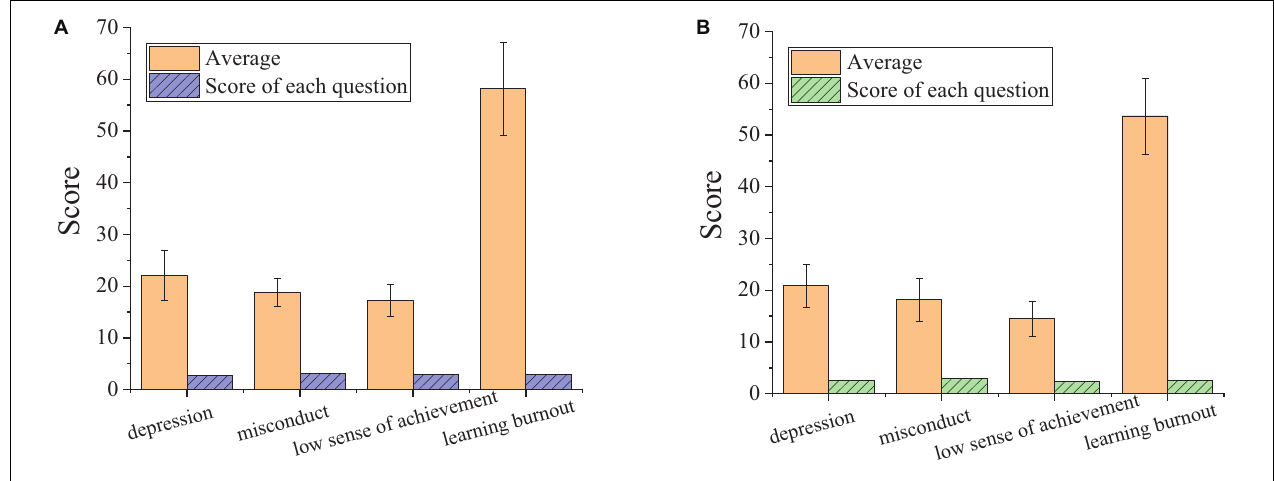
FIGURE 6 | Descriptive statistics for learning burnout of Chinese and Malaysian college students majoring in sports. (A) Sport School of Zhengzhou University. (B) Center for Sport and Exercise Science University of Malaya.